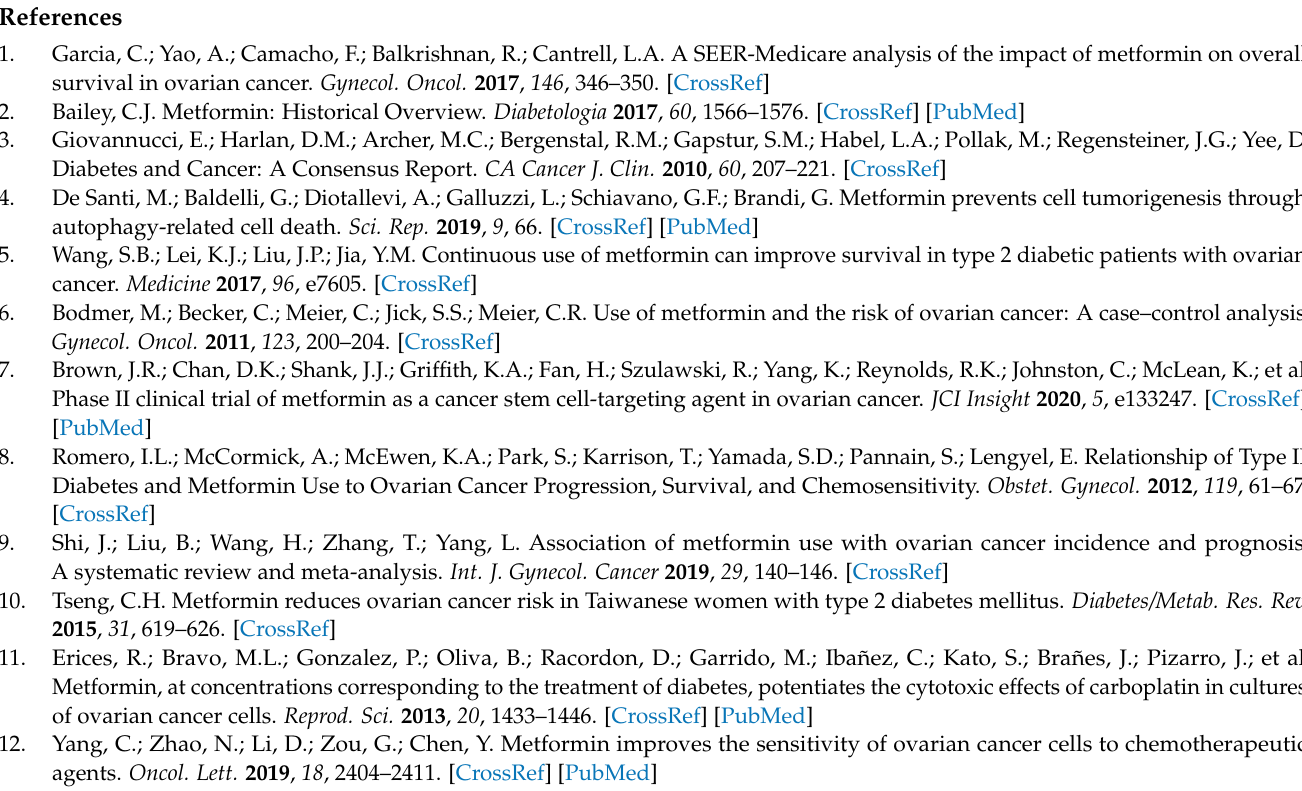
Table S8: Top 5 diseases and function predicted to be activated and inhibited; Figure S1: Effect metformin on the NFKB1 mechanistic network as predicted by IPA; Figure S2: Effect metformin on the ERK signaling pathway predicted by